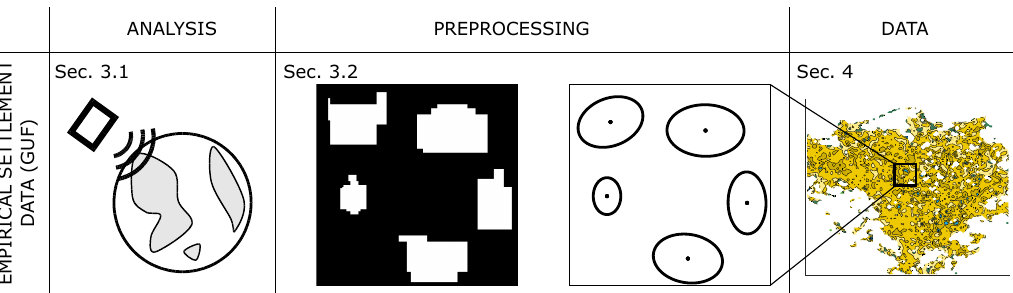
Figure 2. Workflow of this paper starting from the empirical data of the Global Urban Footprint (GUF), a binary settlement map derived from satellite data (Section 3.1) [29,30]. Preprocessing of the data as follows (Section 3.2) by identifying related objects and determine their centre of gravity and analysis of the spatial distribution of the number of objects, density and regularity (Section